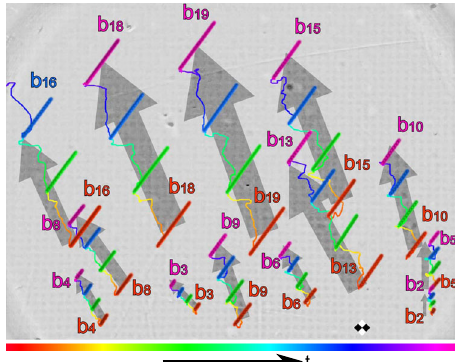
Fig. 4 Experimental trajectories of bipeds with lengths between b 2 and b 19 . The bipeds are driven by a fundamental loop on a pattern with lattice constant a ≈ 7 μ m The color of each of the thirteen bipeds and their trajectories indicates the time progress of the repeating control loop (see colorbar). The biped b 4 shares the same winding number with the biped b 6 . The biped b 16 shares the same winding number with the biped b 18 . The low robustness, ρ = 0.02, causes discrepancies between the theoretically computed and the experimentally observed winding numbers for the bipeds b b c = 1/72. A square region of the 13 and 15 . The compaction of the loop is pattern of diagonal 2 a is sketched for scale and to indicate the relative